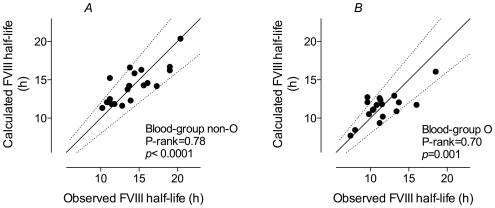
Calculated FVIII half-life versus observed FVIII half-life.Calculated FVIII half-lives were obtained using equations 1 or 2 (Panels A and B, respectively), using pre-infusion VWF and propeptide levels, and are plotted versus observed FVIII half-lives of blood-group non-O (panel A) and blood-group O patients (panel B). Solid lines represent ideal correlation between calculated and observed half-lives, while dotted lines indicate 20% deviation margins.